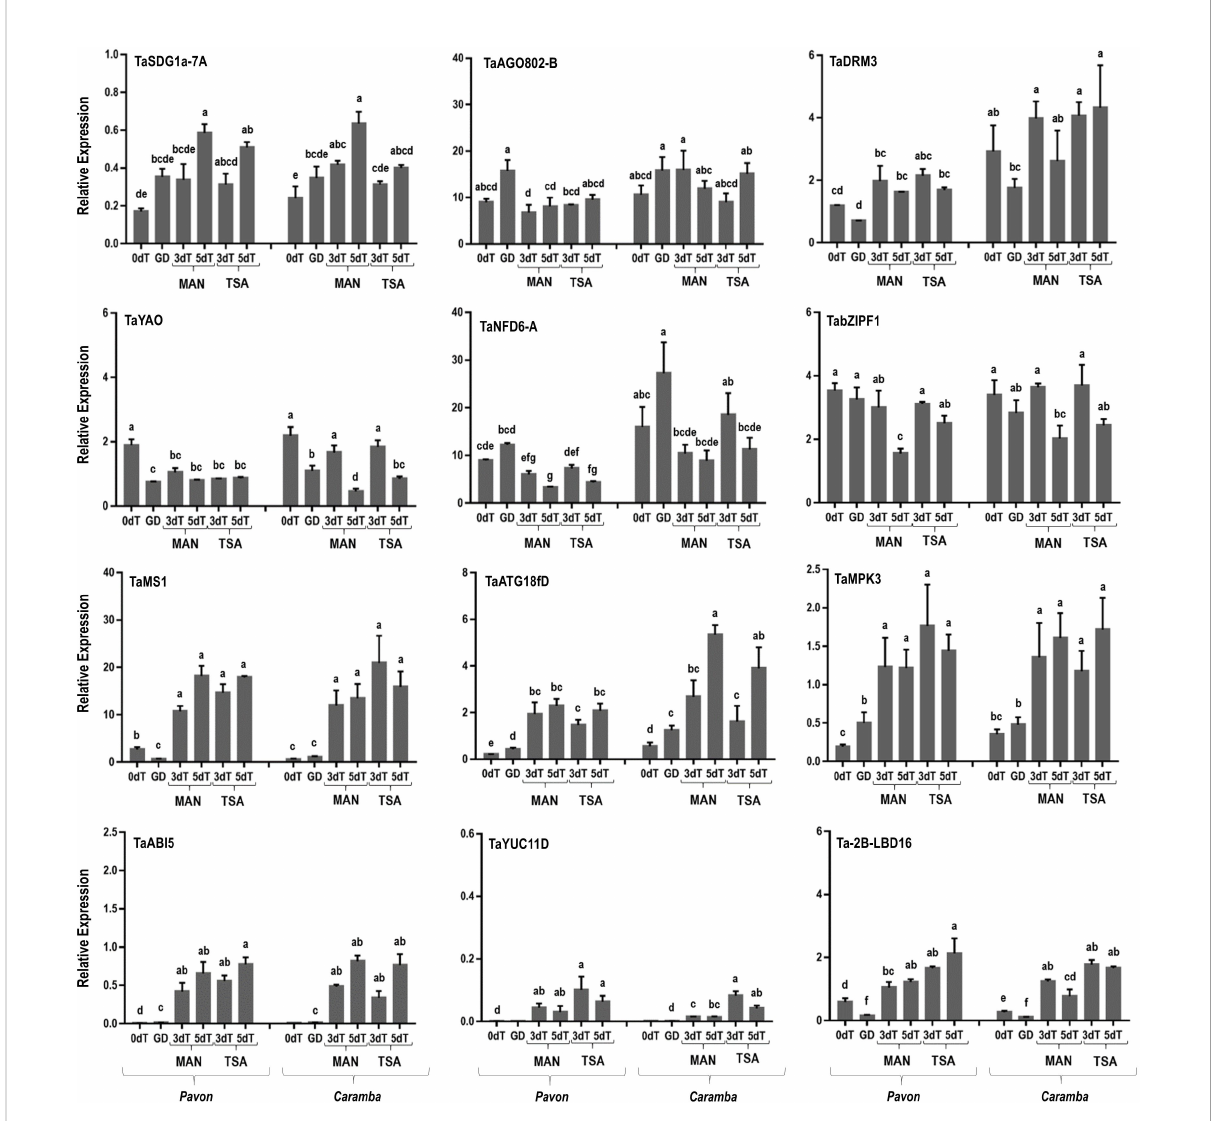
FIGURE 5 qRT-PCR analysis of key genes involved in microspore embryogenesis induction. Microspores before stress treatment (0dT), microspores under gametophytic development (GD), microspores after 3 and 5 days with mannitol treatment (3dT-MAN, 5dT-MAN) and after 3 and 5 days with mannitol plus TSA treatment (3dT-TSA, 5dT-TSA) from Pavon (on the left) and Caramba (on the right). Data were normalized using Ta.27771 and Ta.2291 as endogenous genes control. Bars represent the standard errors of the means. Relative expression values with the same letter are not signi fi cantly different (P ˂ 0.05) according to the Duncan